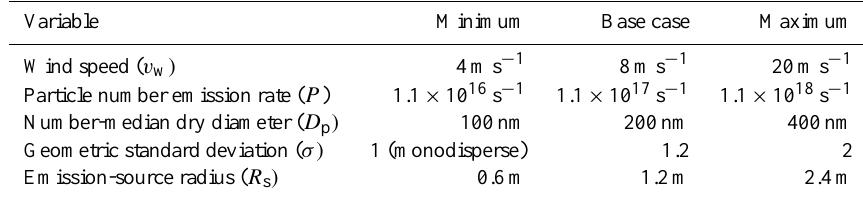
Table 1. The variables explored in the plume modeling and the range of values used for